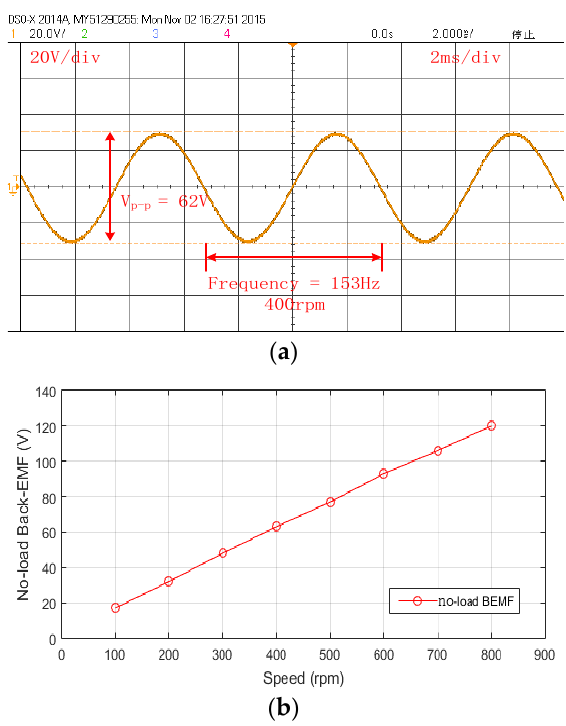
Figure 11. AFPM-M back EMF. ( a ) Line back EMF at the speed of 400 rpm; ( b ) Peak-peak value of the line back EMF from 100 rpm to 800 rpm.